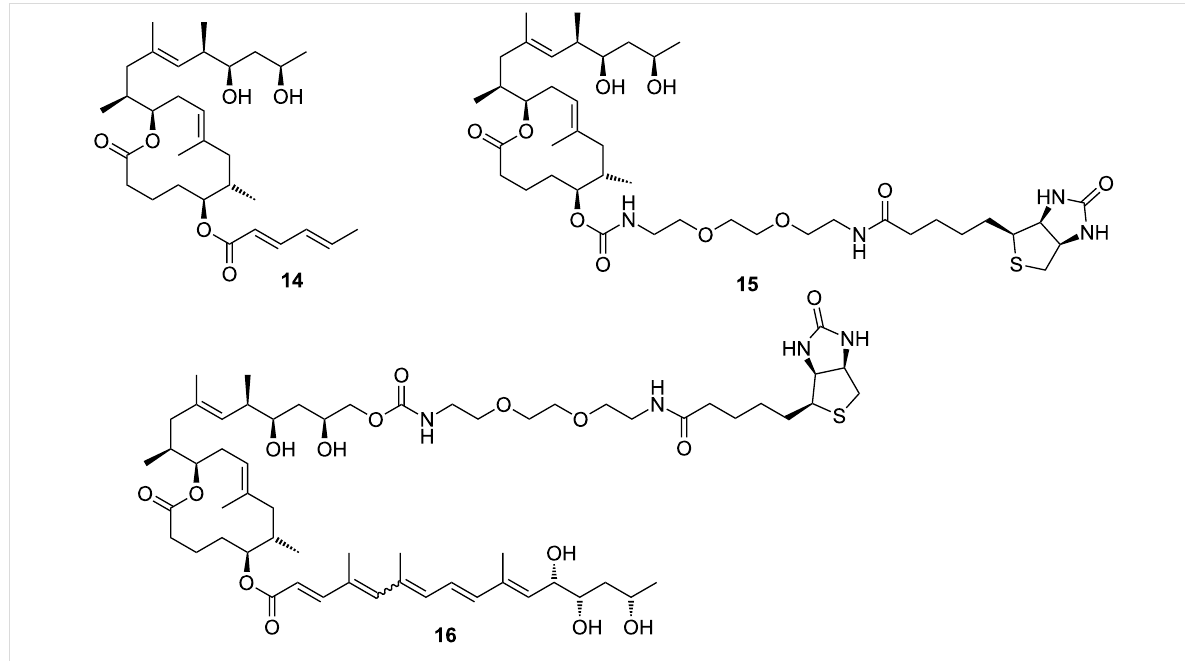
Figure 6: Tool compounds used by Pluschke and co-workers for elucidating the molecular targets of mycolactones.